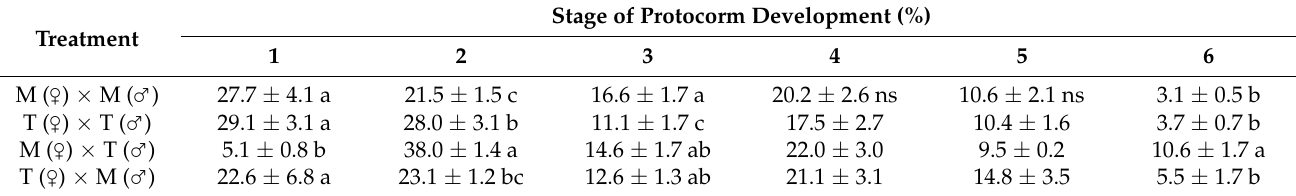
The number of seeds in each treatment are 500 seeds. Values are means ± SE. Different letters within the column indicate significant differences analyzed by DMRT at p <